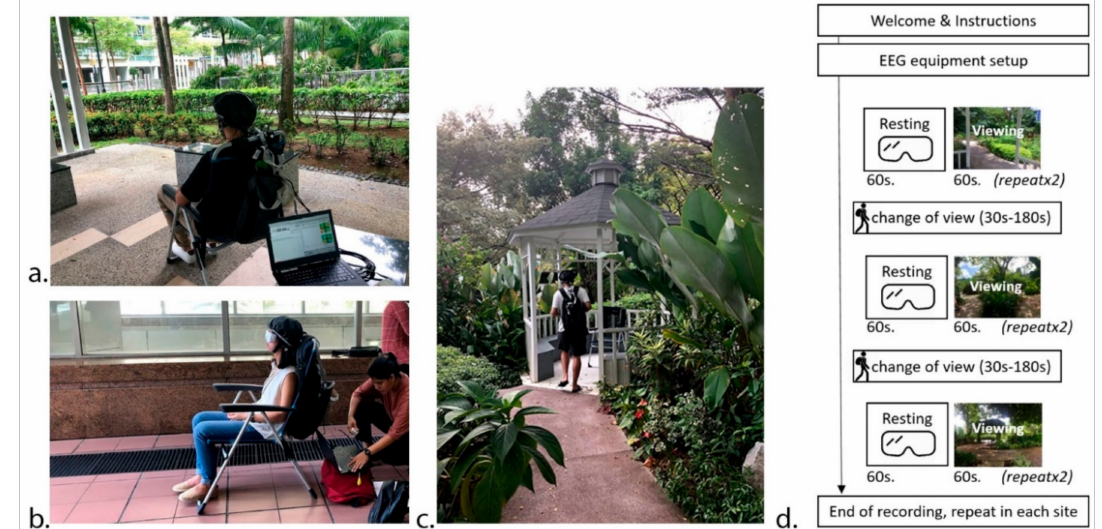
Figure 2. Setup and procedure: ( a ) participant viewing the scene in S2_3, ( b ) participant during resting state in S3_1, ( c ) participant walking between the scenes in Site 1 and ( d ) steps of the in-situ experimental